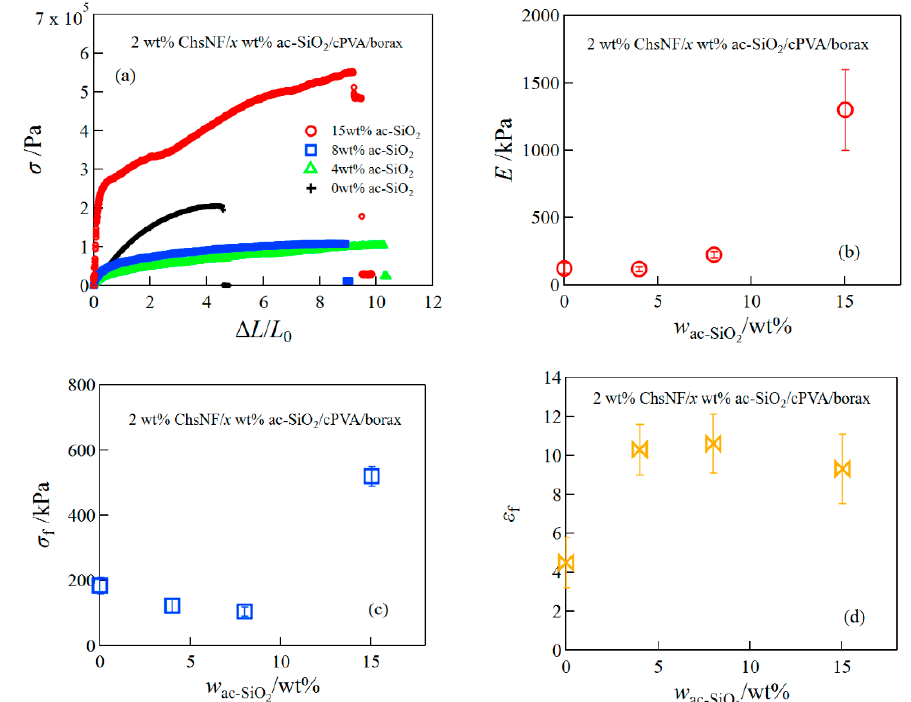
Figure 3. Tensile stress–strain curves ( a ), the Young ′ s modulus ( b ), fracture stress ( c ), and fracture strain ( d ) for ChsNF/ac-SiO 2 /cPVA/borax hydrogels.